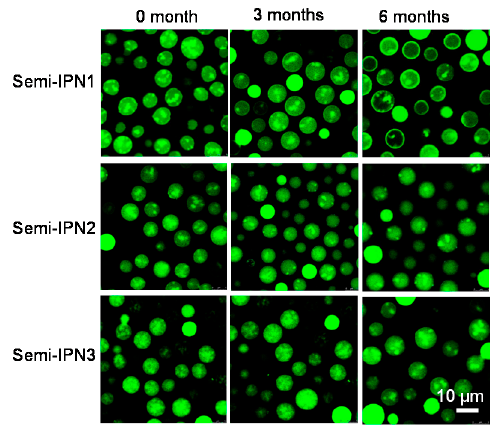
Figure 11. CLSM images of the semi-IPN microspheres at different storage times (4 °C, 10 mM pH 7.0 PBS solution; the samples were labeled with Rh 123).